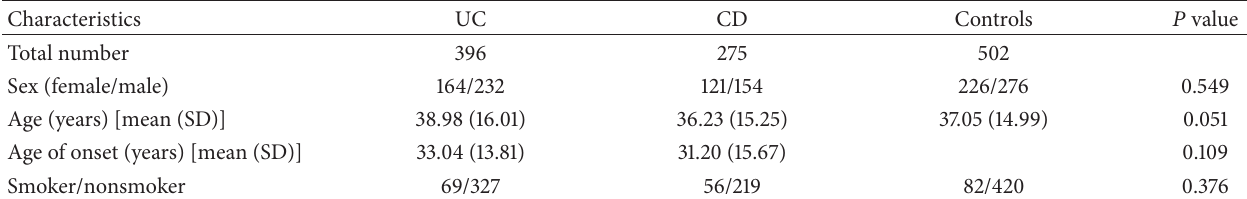
Table 1: Demographic characteristics of IBD patients and the